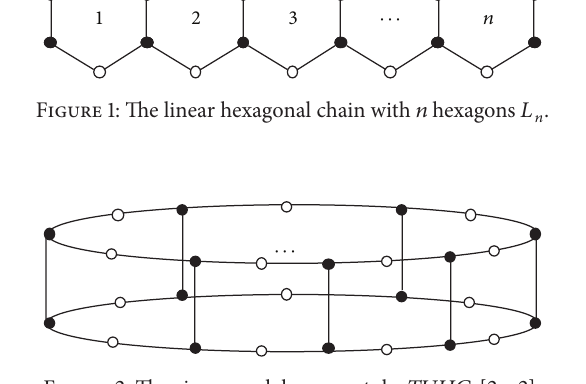
Figure 2: The zig-zay polyhex nanotube 𝑇𝑈𝐻𝐶 6 [2𝑛, 2]